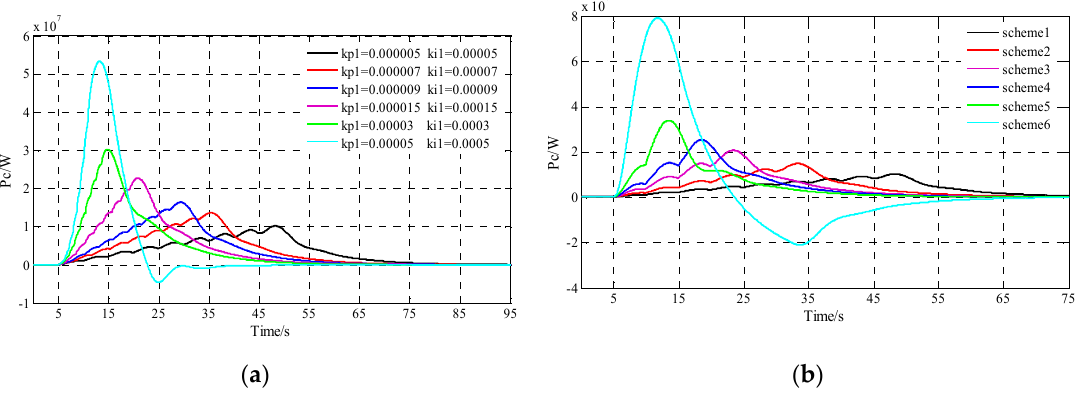
Figure 19. Change diagram of converter power. ( a ) different response times; ( b ) different number of segments.